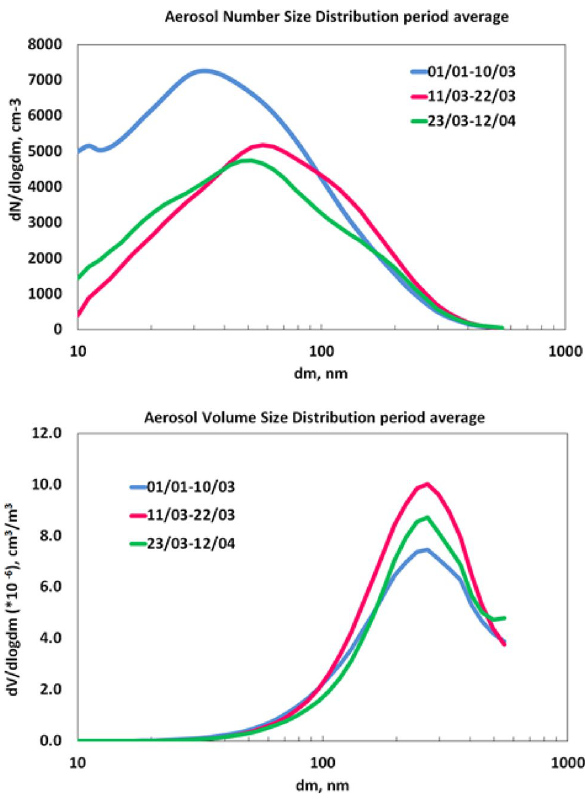
Figure 5. Aerosol Number and volume Size distribution during the lockdown and reference